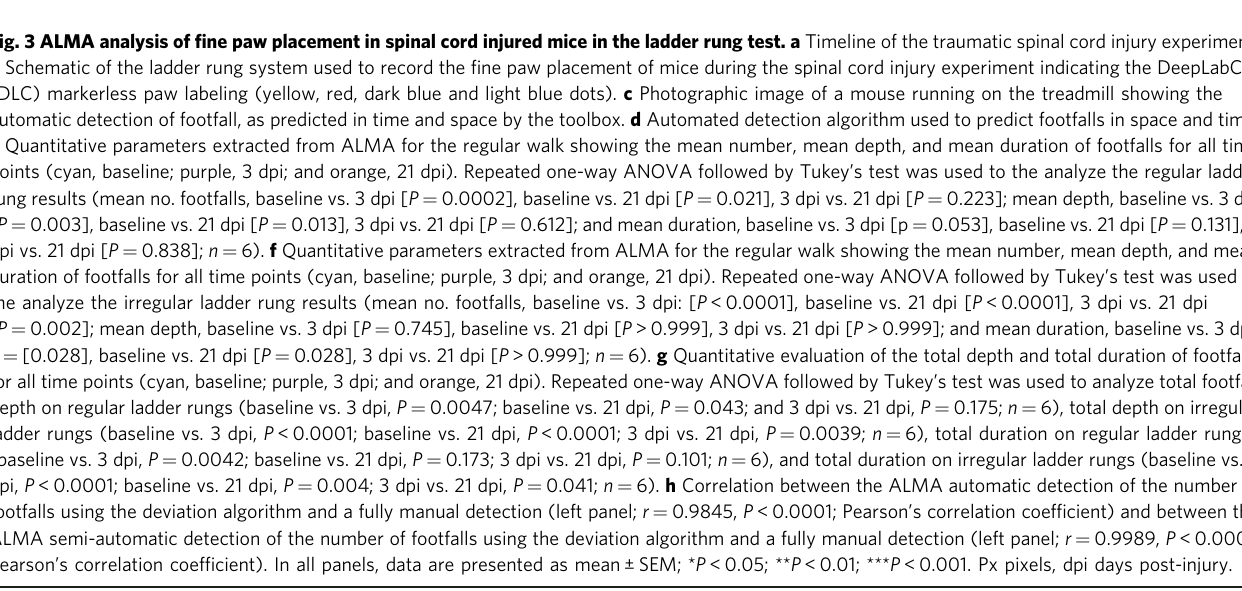
Fig. 3 ALMA analysis of fi ne paw placement in spinal cord injured mice in the ladder rung test. a Timeline of the traumatic spinal cord injury experiment. b Schematic of the ladder rung system used to record the fi ne paw placement of mice during the spinal cord injury experiment indicating the DeepLabCut (DLC) markerless paw labeling (yellow, red, dark blue and light blue dots). c Photographic image of a mouse running on the treadmill showing the automatic detection of footfall, as predicted in time and space by the toolbox. d Automated detection algorithm used to predict footfalls in space and time. e Quantitative parameters extracted from ALMA for the regular walk showing the mean number, mean depth, and mean duration of footfalls for all time points (cyan, baseline; purple, 3 dpi; and orange, 21 dpi). Repeated one-way ANOVA followed by Tukey ’ s test was used to the analyze the regular ladder rung results (mean no. footfalls, baseline vs. 3 dpi [ P = 0.0002], baseline vs. 21 dpi [ P = 0.021], 3 dpi vs. 21 dpi [ P = 0.223]; mean depth, baseline vs. 3 dpi [ P = 0.003], baseline vs. 21 dpi [ P = 0.013], 3 dpi vs. 21 dpi [ P = 0.612]; and mean duration, baseline vs. 3 dpi [p = 0.053], baseline vs. 21 dpi [ P = 0.131], 3 dpi vs. 21 dpi [ P = 0.838]; n = 6). f Quantitative parameters extracted from ALMA for the regular walk showing the mean number, mean depth, and mean duration of footfalls for all time points (cyan, baseline; purple, 3 dpi; and orange, 21 dpi). Repeated one-way ANOVA followed by Tukey ’ s test was used to the analyze the irregular ladder rung results (mean no. footfalls, baseline vs. 3 dpi: [ P < 0.0001], baseline vs. 21 dpi [ P < 0.0001], 3 dpi vs. 21 dpi [ P = 0.002]; mean depth, baseline vs. 3 dpi [ P = 0.745], baseline vs. 21 dpi [ P > 0.999], 3 dpi vs. 21 dpi [ P > 0.999]; and mean duration, baseline vs. 3 dpi, P = [0.028], baseline vs. 21 dpi [ P = 0.028], 3 dpi vs. 21 dpi [ P > 0.999]; n = 6). g Quantitative evaluation of the total depth and total duration of footfalls for all time points (cyan, baseline; purple, 3 dpi; and orange, 21 dpi). Repeated one-way ANOVA followed by Tukey ’ s test was used to analyze total footfall depth on regular ladder rungs (baseline vs. 3 dpi, P = 0.0047; baseline vs. 21 dpi, P = 0.043; and 3 dpi vs. 21 dpi, P = 0.175; n = 6), total depth on irregular ladder rungs (baseline vs. 3 dpi, P < 0.0001; baseline vs. 21 dpi, P < 0.0001; 3 dpi vs. 21 dpi, P = 0.0039; n = 6), total duration on regular ladder rungs (baseline vs. 3 dpi, P = 0.0042; baseline vs. 21 dpi, P = 0.173; 3 dpi vs. 21 dpi, P = 0.101; n = 6), and total duration on irregular ladder rungs (baseline vs. 3 dpi, P < 0.0001; baseline vs. 21 dpi, P = 0.004; 3 dpi vs. 21 dpi, P = 0.041; n = 6). h Correlation between the ALMA automatic detection of the number of footfalls using the deviation algorithm and a fully manual detection (left panel; r = 0.9845, P < 0.0001; Pearson ’ s correlation coef fi cient) and between the ALMA semi-automatic detection of the number of footfalls using the deviation algorithm and a fully manual detection (left panel; r = 0.9989, P < 0.0001; Pearson ’ s correlation coef fi cient). In all panels, data are presented as mean ± SEM; * P < 0.05; ** P < 0.01; *** P < 0.001. Px pixels, dpi